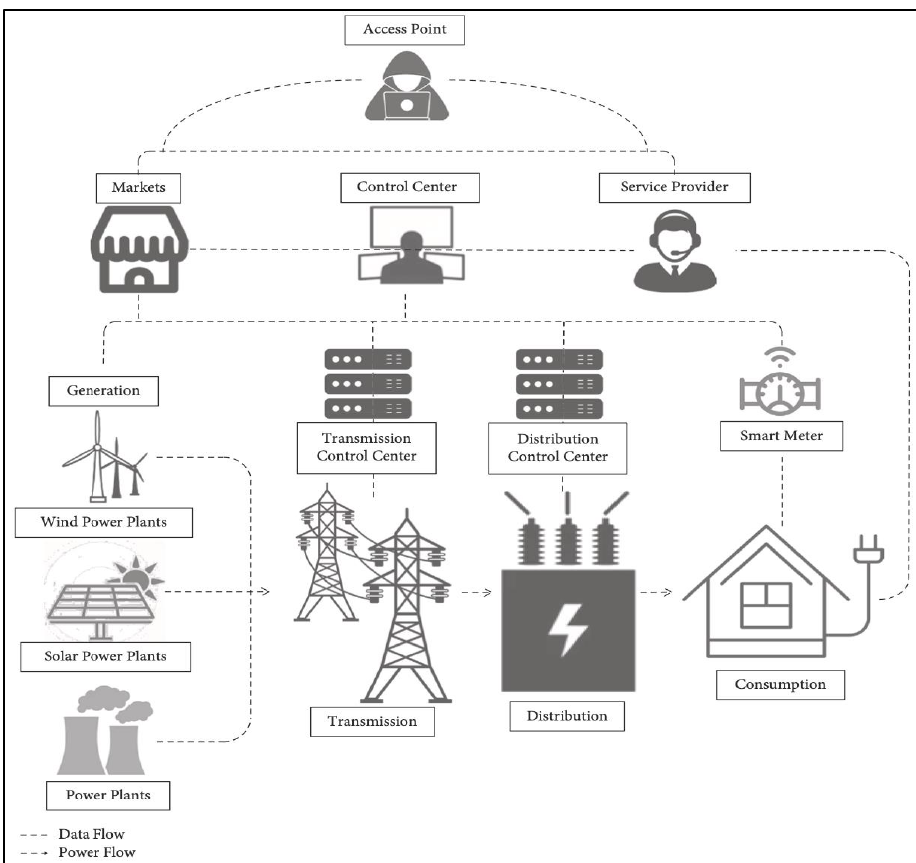
Figure 1. Smart grid